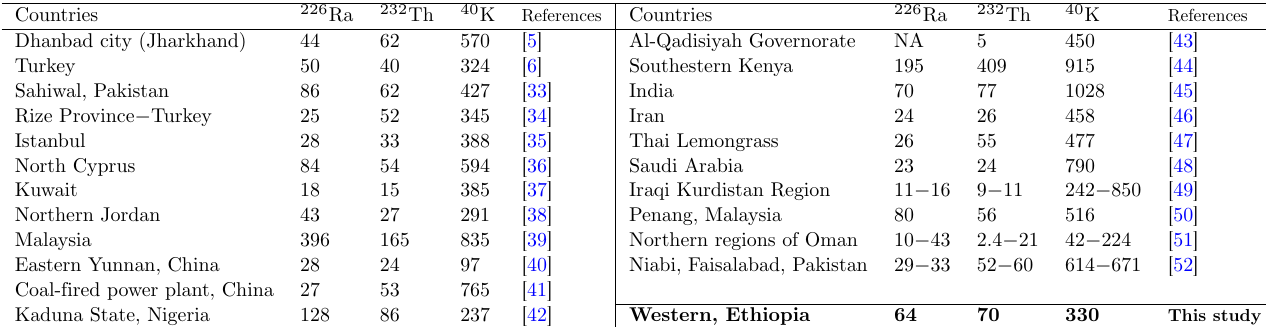
Table 2. Comparison of mean activity concentrations selected